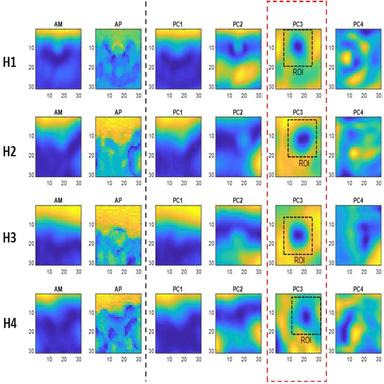
Images of FBHs reconstructed by features: average magnitude (AM), average phase (AP), and principal components (PC1-PC4) with ROI.